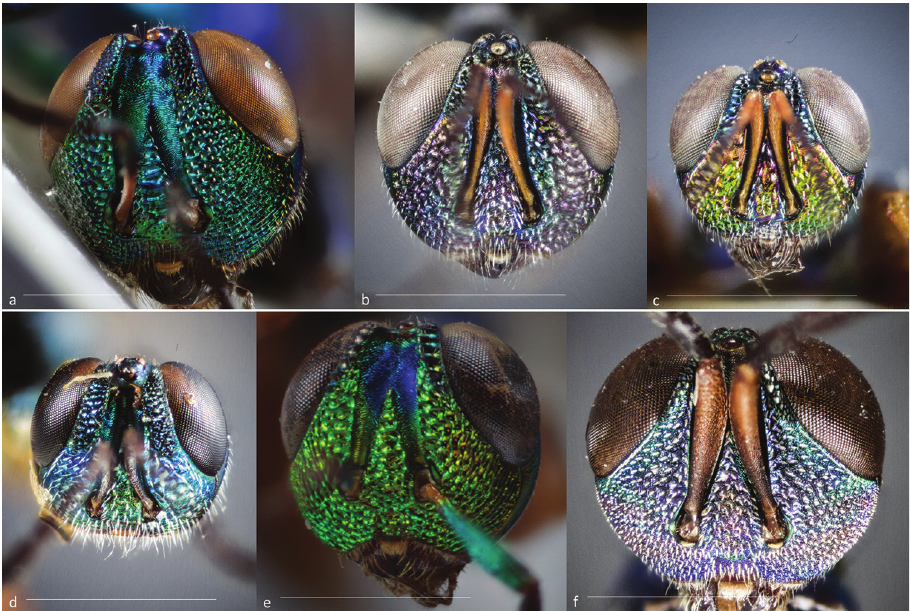
Figure 6. Head (frontal) II a O. gracilis Westwood (imaged specimen: OGr01) b O. heikewernerae sp. n. (OHe01, holotype) c O. hoggarensis Hedqvist (OHo02, paratype) d O. leibnizi sp. n. (OLe03, paratype) e O. longicollis (Cameron) (OLo01) f O. madegassa Bouček (OMad01, holotype). Scale bars: 1